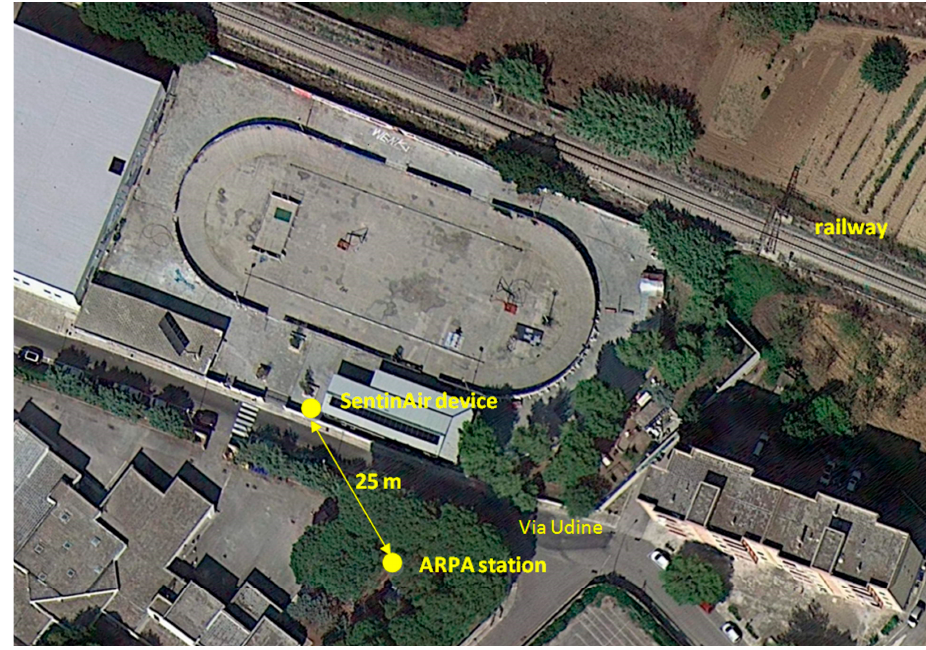
Figure 4. Depiction of the site where the ARPA station was